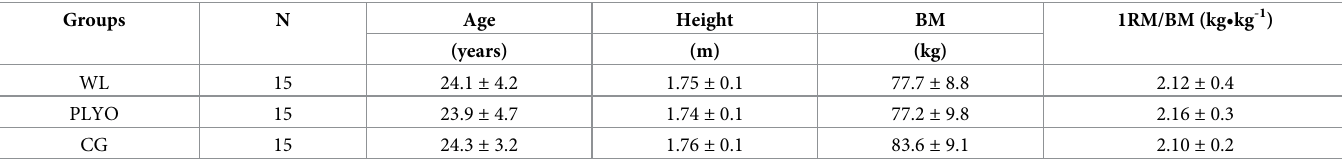
Table 1. Participants’ characteristics at